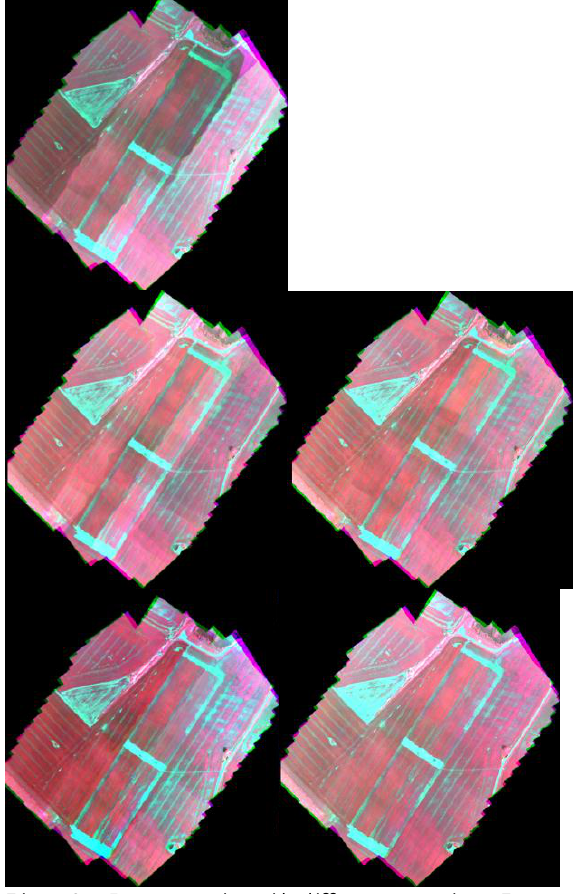
Figure 8. Image mosaics with different corrections. From top left to bottom: no correction, rel UAV, rel ground, BA: relB, BRDF; BA: relA (Section 3.4).